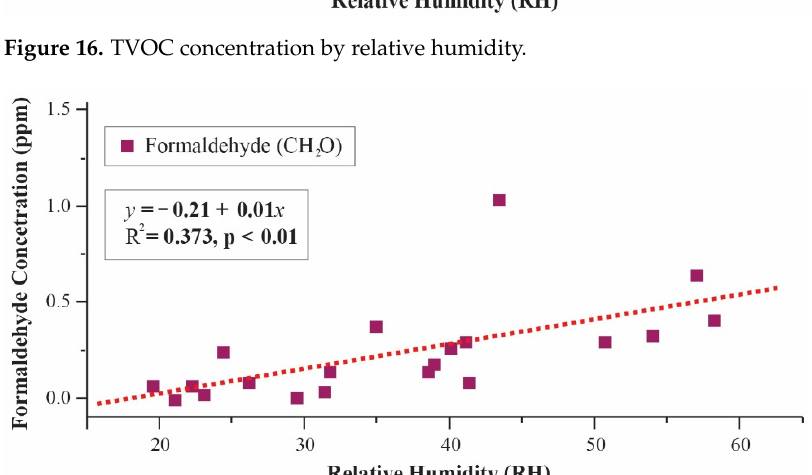
Figure 17. Formaldehyde (CH 2 O) concentration by relative humidity.